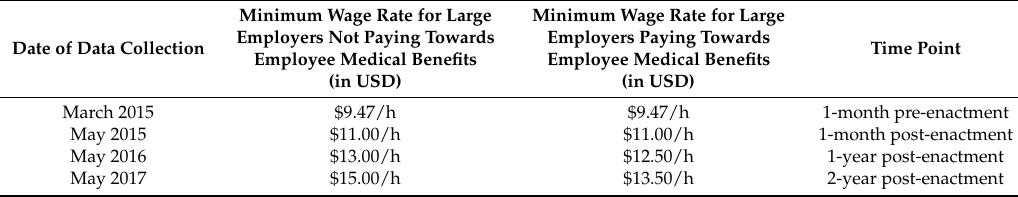
Table A1. Timeline of Seattle’s minimum wage increase during data collection.